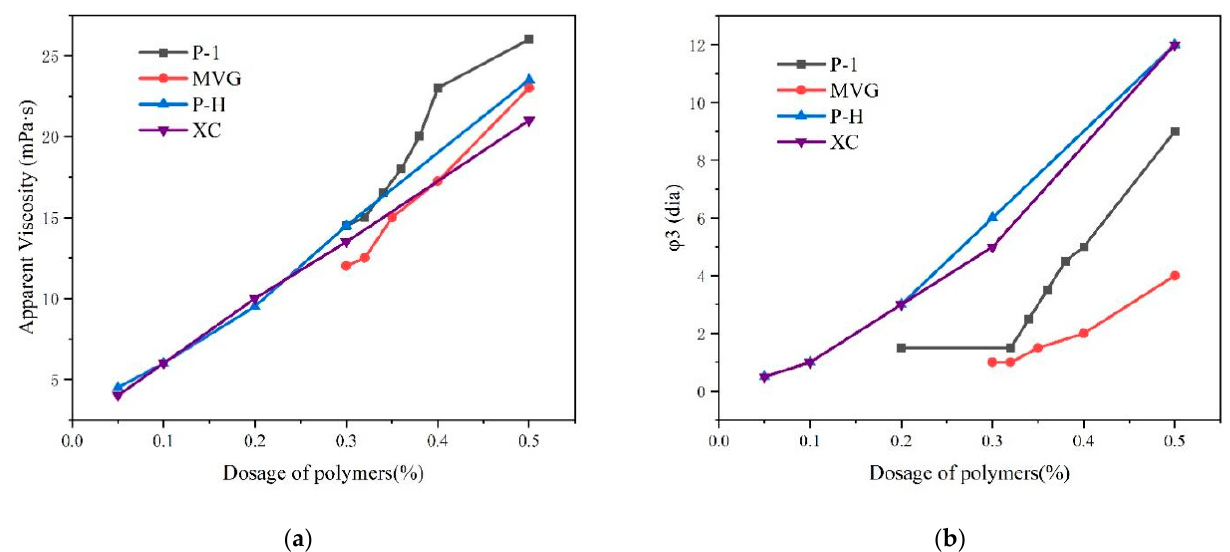
Figure 4. Apparent viscosity ( a ) and Φ 3 ( b ) values of sea salt slurries containing the polymers at different concentrations.